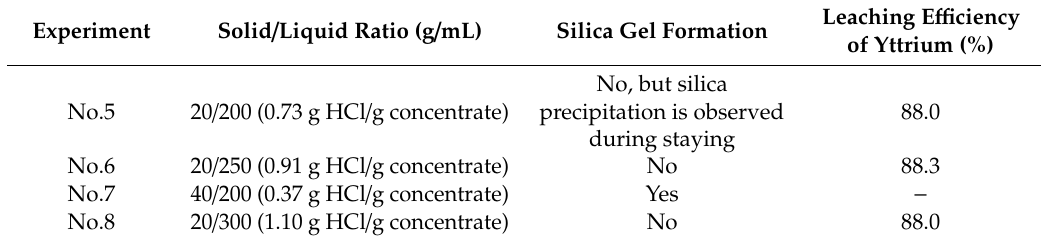
Table 4. The influence of solid / liquid ratio on the leaching e ffi ciency of yttrium (90 ◦ C, 2 h).